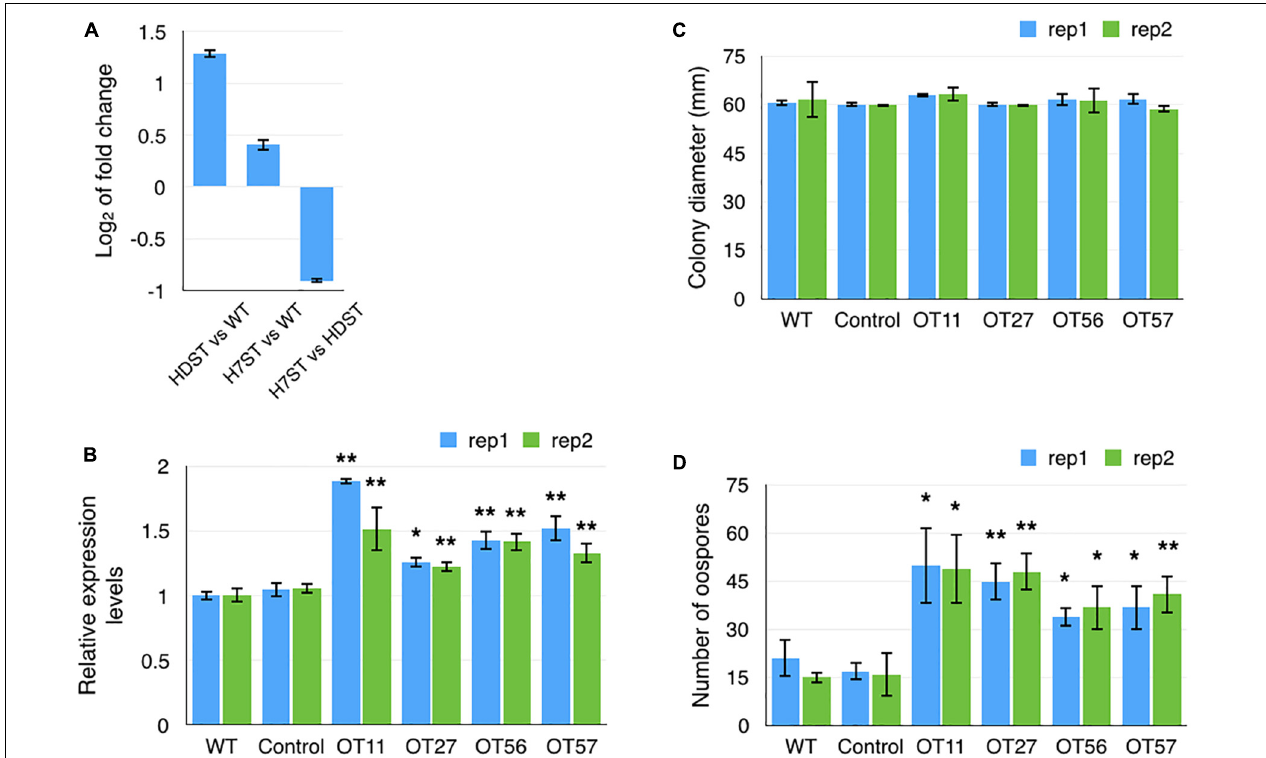
FIGURE 9 | Transcription factor gene PITG_10861 promotes the production of hormone α 2. (A) Fold-changes to PITG_10861 expression levels in the HDST, H7ST, and wild-type strains. Relative expression levels (B) and colony diameters (C) of wild-type, empty vector control, and four PITG_10861- overexpressing transformants. (D) Oospore production in the A1 strain induced by the wild-type, empty vector control, and four PITG_10861- overexpressing transformants. * p < 0.05; ** p <